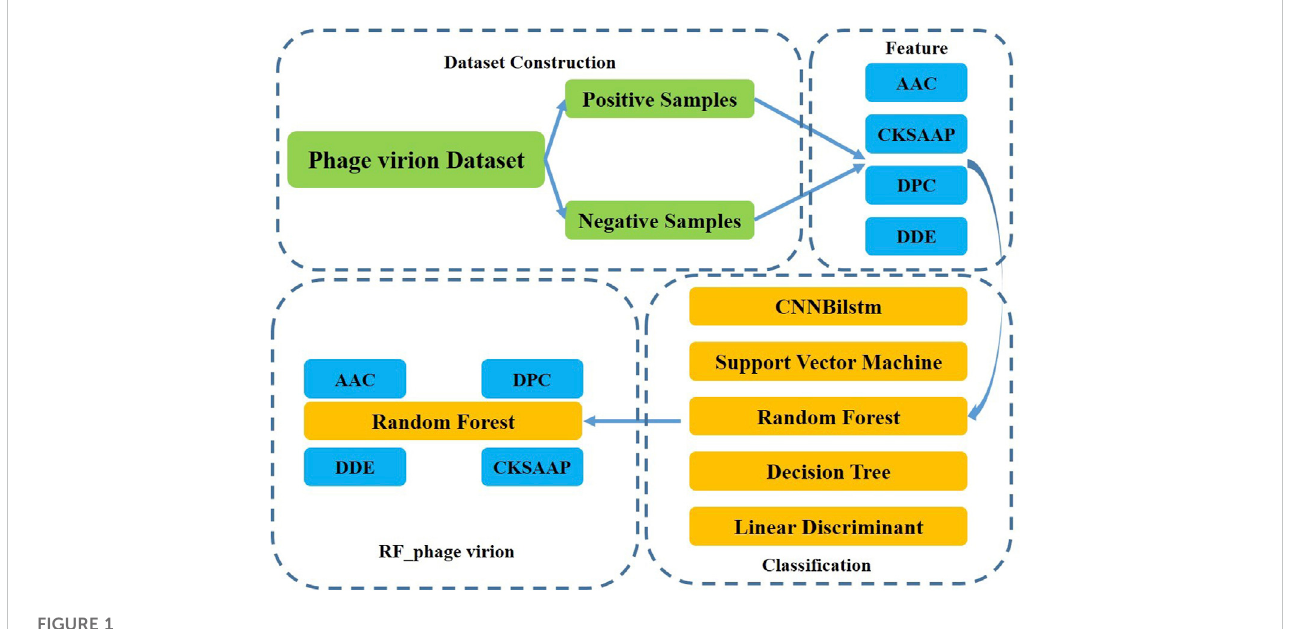
FIGURE 1 The outlines of RF_phage virion.